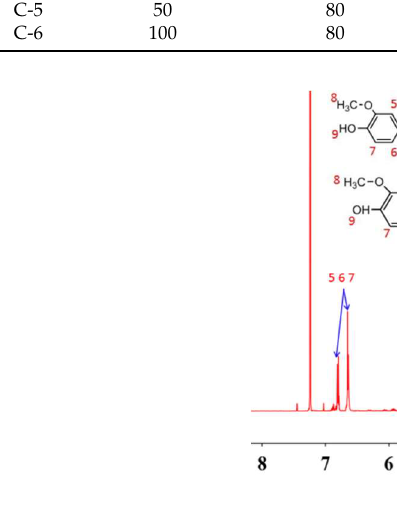
Figure 4. 1 H NMR spectrum of sample C-2.